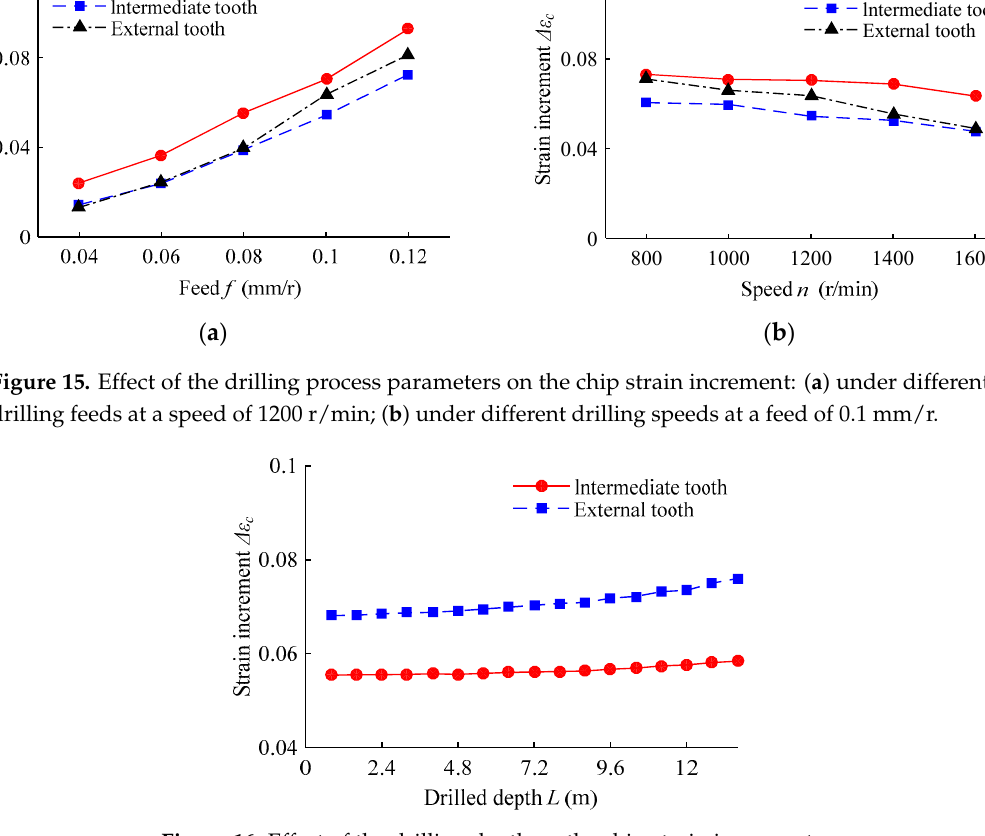
Figure 16. Effect of the drilling depth on the chip strain increment.